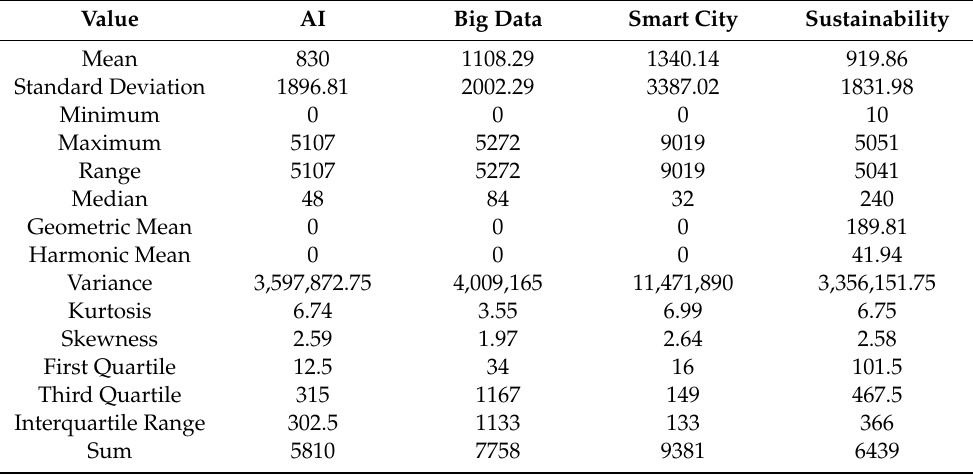
Table A1. Descriptive statistics for demand on energy managers positions by country (see Table